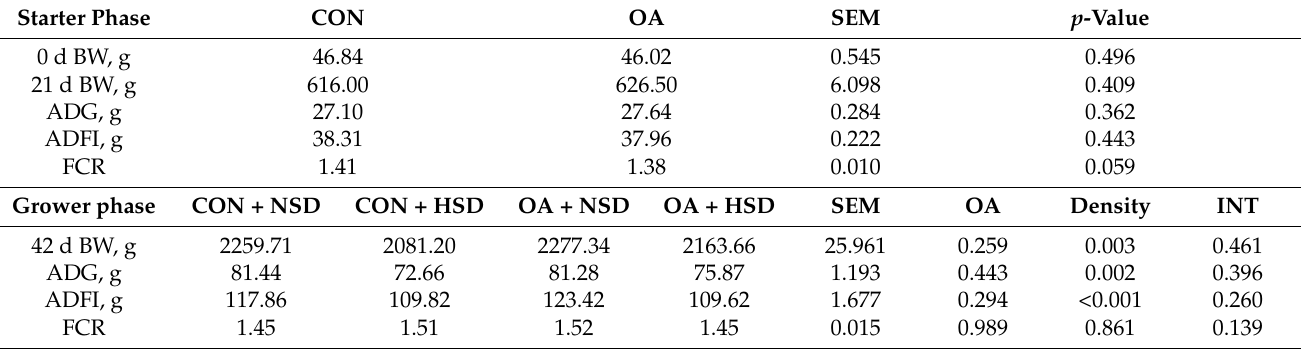
Table 1. Effects of organic acids on growth performance in broilers at starter and grower phases 1